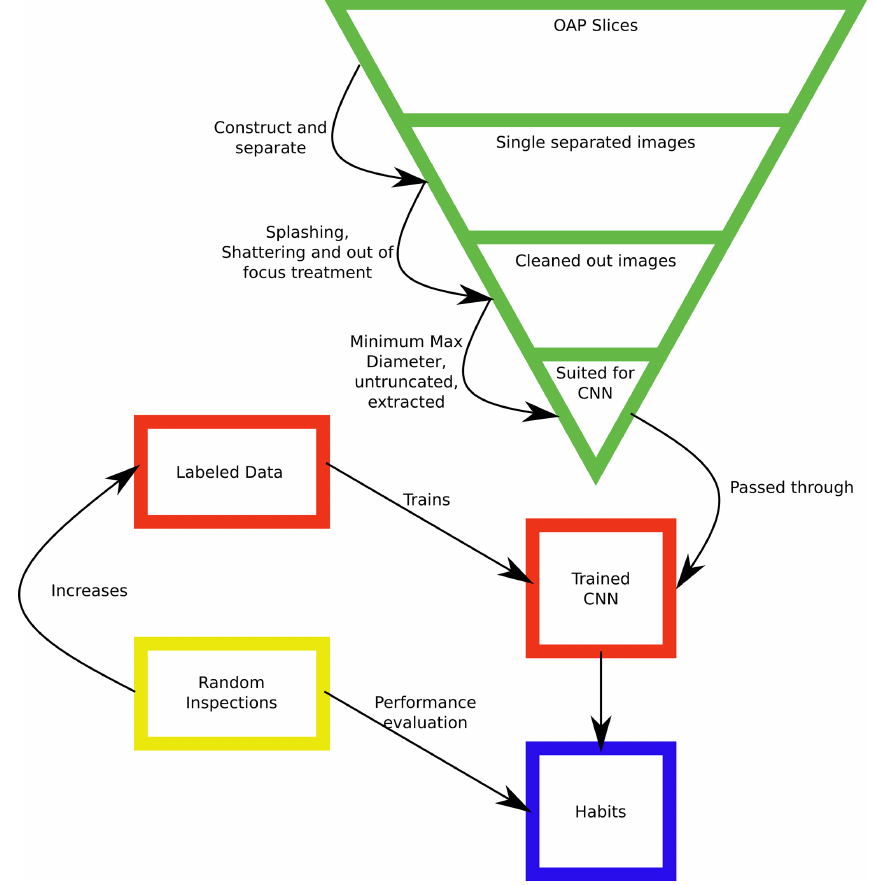
Figure A6. Ideal use of the algorithm, which allows for improvements of the training set over time and performance evaluation.